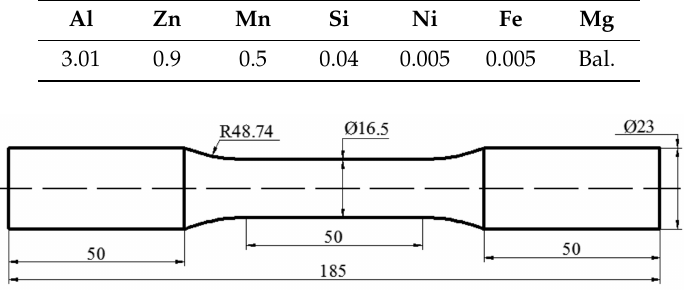
Figure 1. Shape and dimensions of the sample (unit:mm).